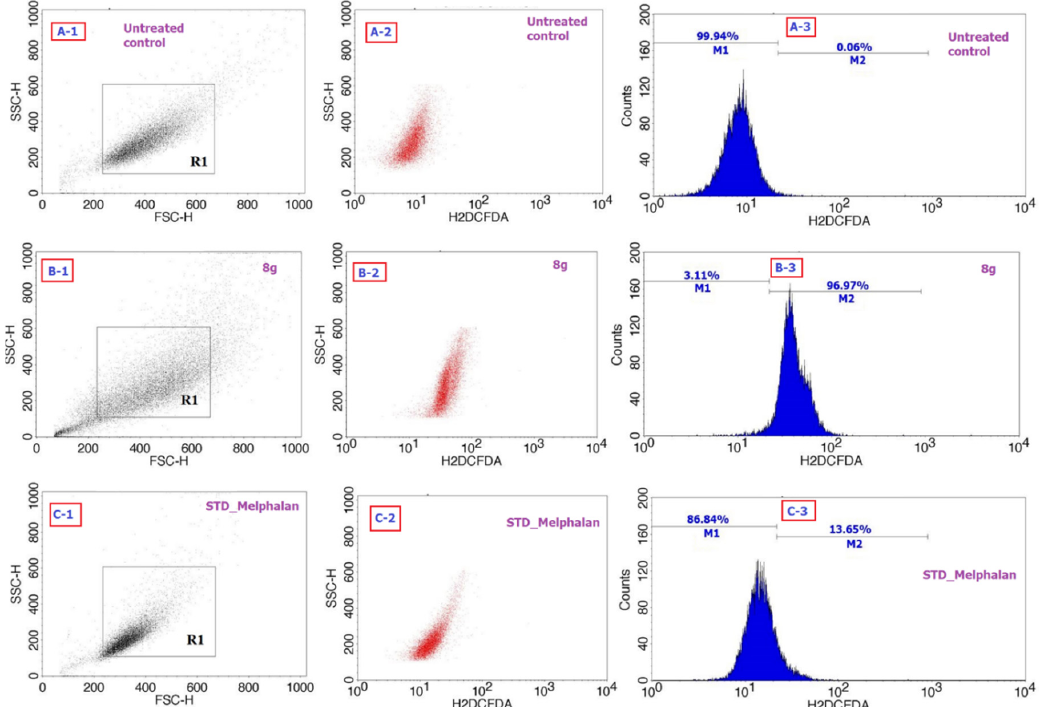
Figure 6. Reactive oxygen species (ROS) generation as a measure of fluorescence intensity in the HepG2 cells following the negative control having no cell treatment ( A ), the treatment of compound 8g ( B ), and the positive control melphalan ( C ) over a 48 h period.